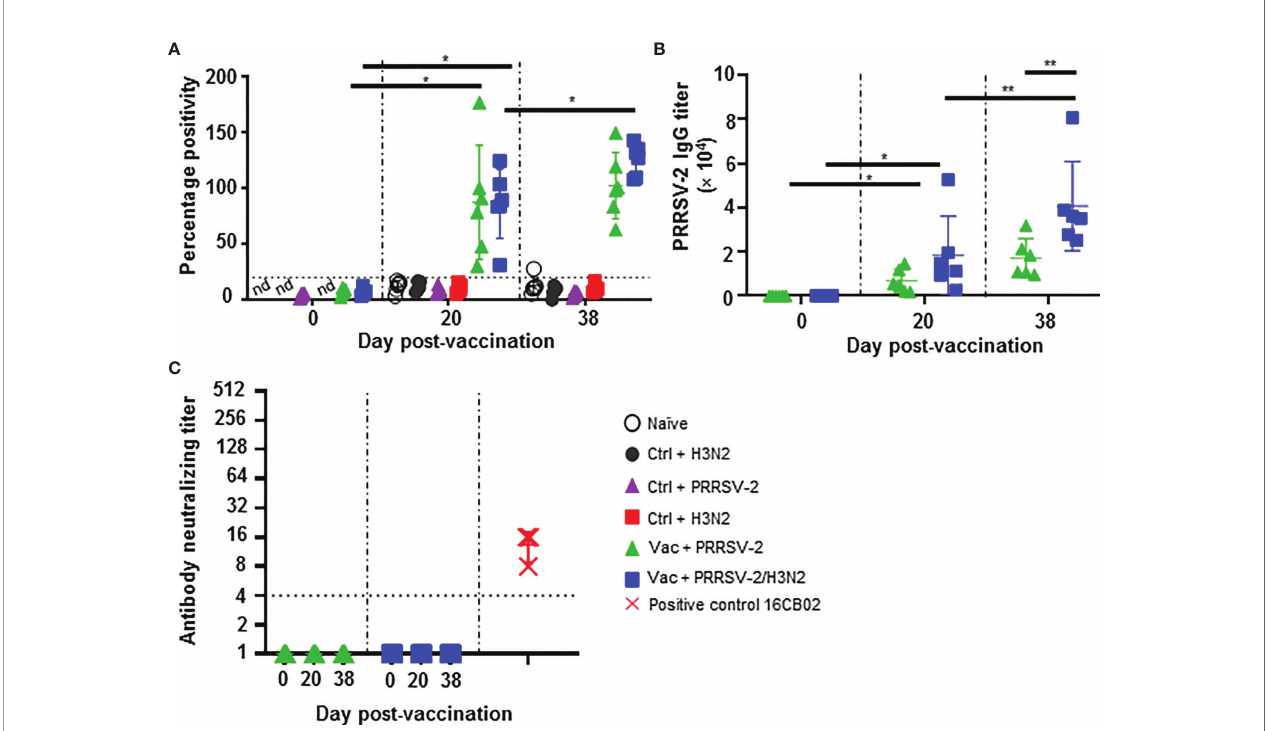
FIGURE 3 | Antibody responses against PRRSV-2. (A) Detection of PRRSV N-speci fi c Abs in serum at 0, 20 and 38 dpv was performed with a commercial ELISA test. The positive threshold is indicated with a horizontal dashed line. (B) PRRSV-speci fi c Ab titers were measured in the sera of PRRS-immunized pigs at 0, 20 and 38 dpv with an in-house ELISA test. (C) Virus neutralizing Ab titers in the serum of PRRS-vaccinated pig at 0, 20 and 38 are shown. Sera from PRRSV-2 infected pigs from an unrelated study were used as positive controls (red symbols). Each pig serum is shown as a symbol within the indicated group (n = 6 per group) and the mean ± SD is represented. Starting dilution is indicated with dashed line. The comparison between the percentage positivity values or Ab titers measured at 20 and 38 dpv versus at 0 dpv for each vaccinated group were performed using the Wilcoxon test. Comparisons between groups were made using the Mann-Whitney test. Asterisks indicate signi fi cant differences (*p < 0.05; **p < 0.01). nd, not